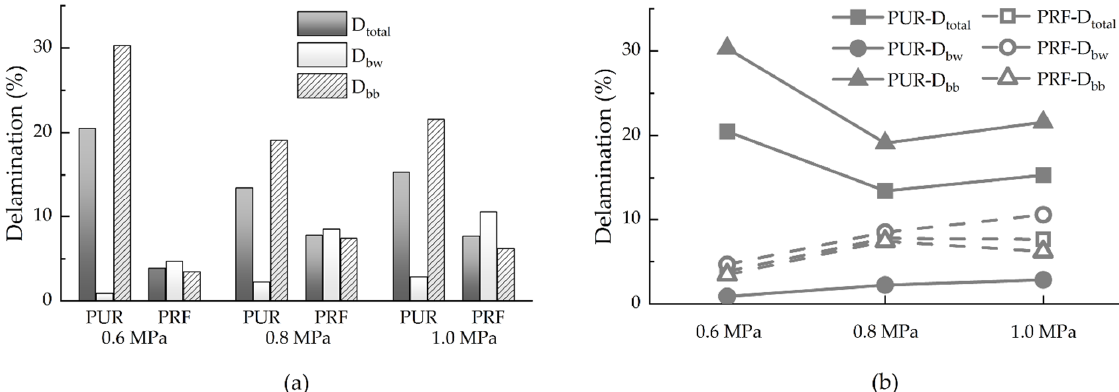
Figure 7. Delamination results for different configurations of CLBT: ( a ) delamination of CLBT spec- imens, ( b ) the trend of delamination of CLBT